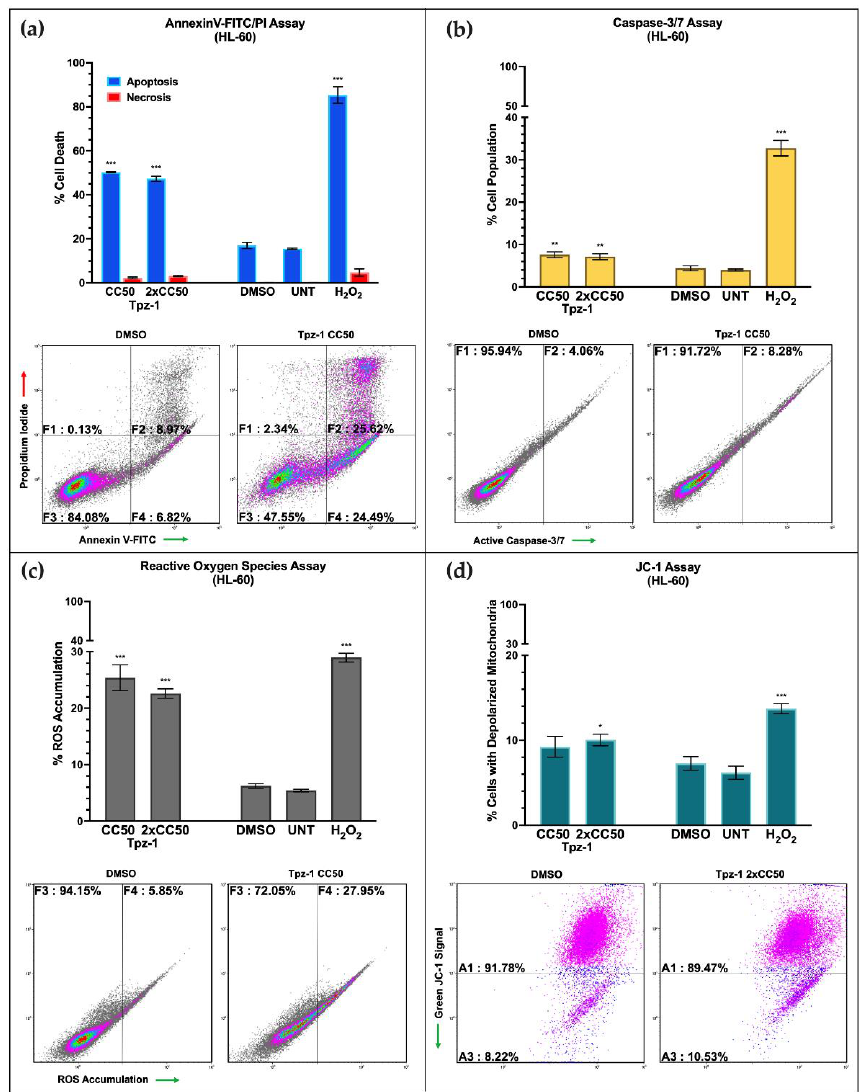
Figure 3. The intrinsic apoptosis pathway mediates Tpz-1-induced cell death. ( a ) Analysis of phos- phatidylserine externalization by flow cytometry showed apoptosis induction in HL-60 cells after 24 h of exposure to CC 50 (0.95 µ M; p < 0.00001) and 2xCC 50 (1.9 µ M; p < 0.00001) concentrations of Tpz-1. The percentages displayed represent total (early and late) apoptosis values. ( b ) Flow cytometry analysis indicated that Tpz-1 CC 50 (0.95 µ M; p = 0.00646) and 2xCC 50 (1.9 µ M; p = 0.005941) concen- trations induced significant caspase-3/7 activation after 6 h of incubation in HL-60 cells. Positive fluorescence for NucView 488 Caspase-3/7 substrate indicated caspase-3/7 activation. ( c ) Tpz-1 causes reactive oxygen species accumulation in HL-60 cells at CC 50 (0.95 µ M; p = 0.000139) and 2xCC 50 (1.9 µ M; p < 0.00001) concentrations. ROS was quantified using the carboxy-H 2